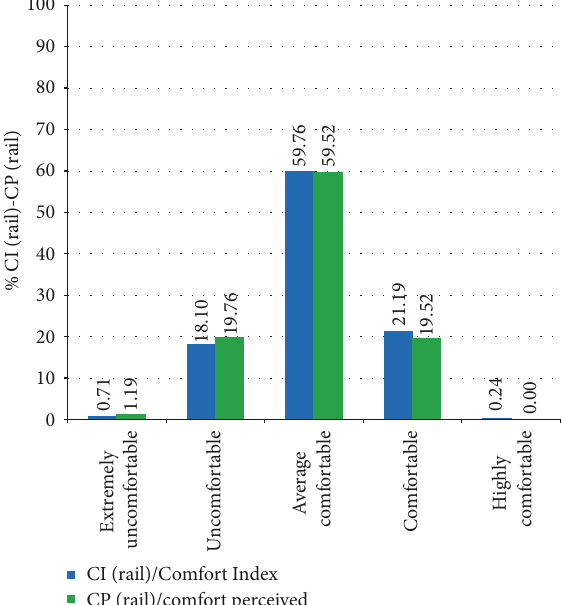
Figure 16: Comparison CI and CP-FIAT